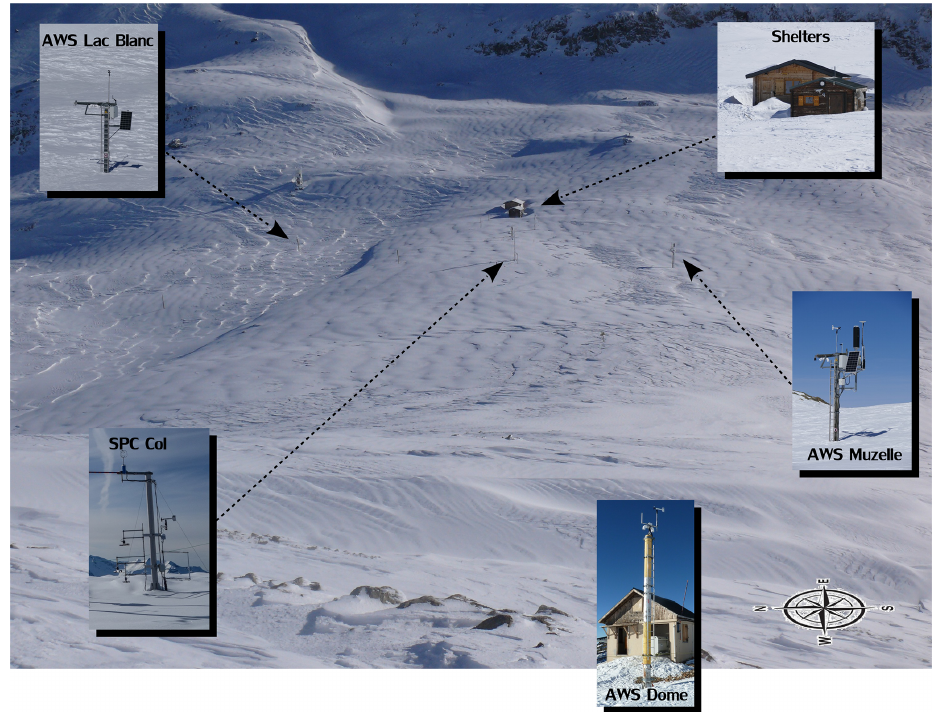
Figure 2. Overview of the experimental site at Col du Lac Blanc (2720ma.s.l., Grandes Rousses mountain range, France). Insets show a detailed view of each AWS. AWS Dome lies outside the picture. See text for further details on each AWS. The approximate area covered by the picture is shown on Fig.